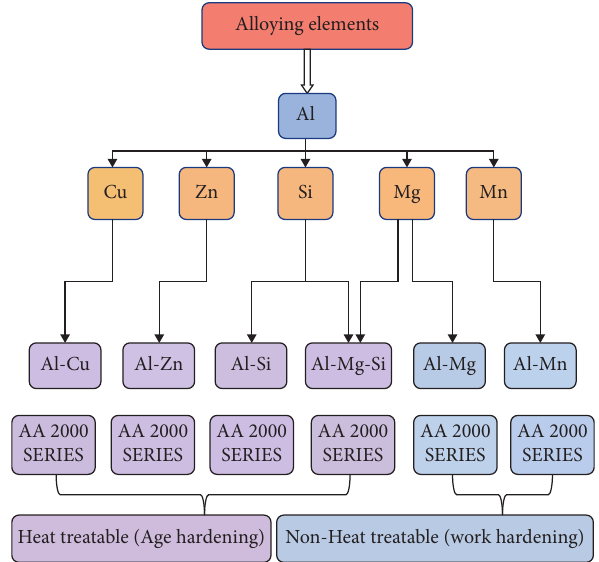
Figure 1: List of wrought aluminum alloy.